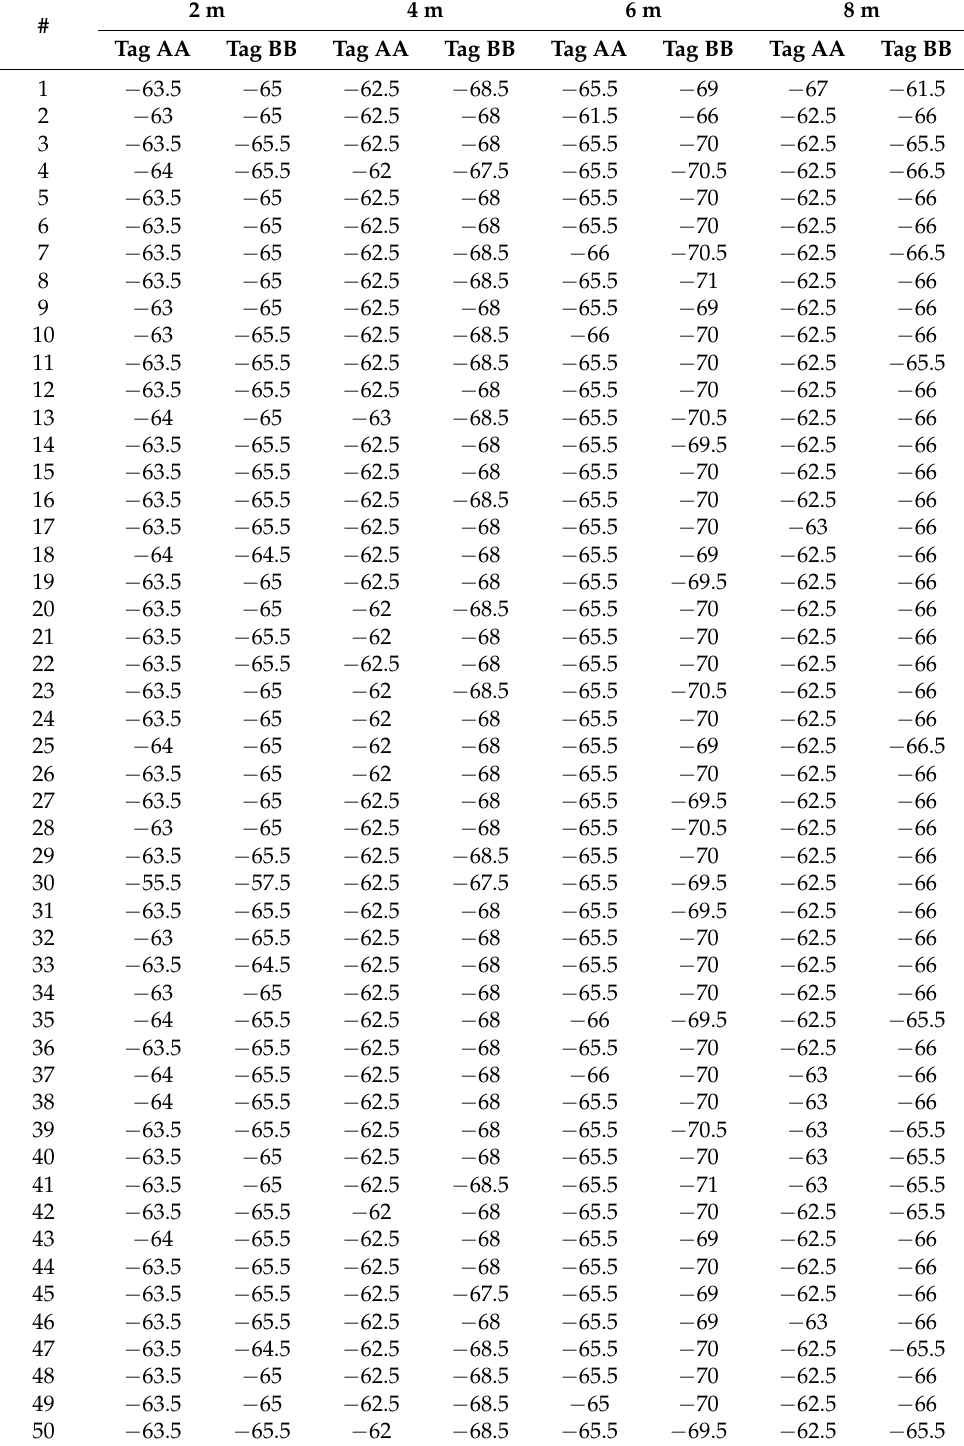
Table A1. RSSI in dBm for individual